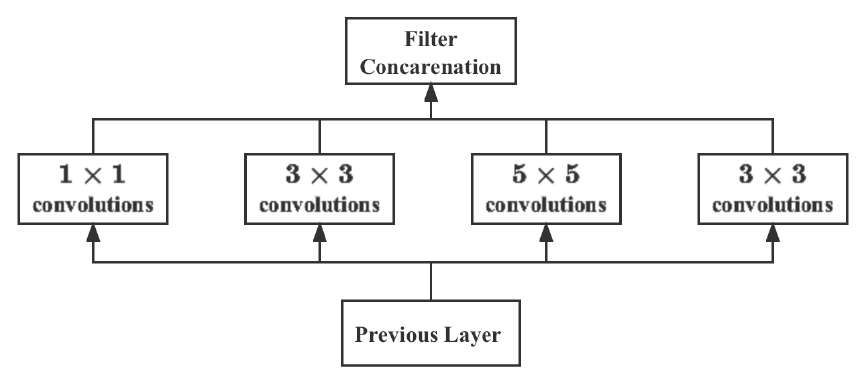
Figure 8. Original inception